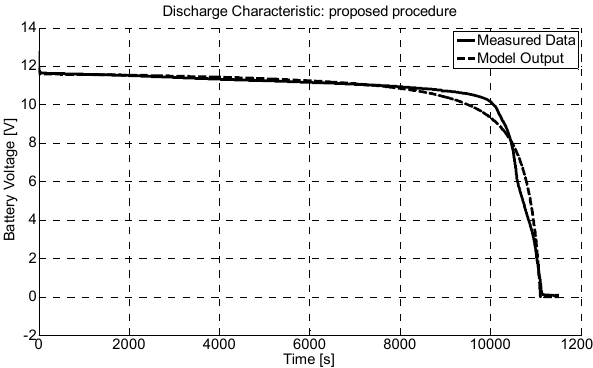
Figure 6. Measured discharge curve and model output with parameters from proposed procedure.